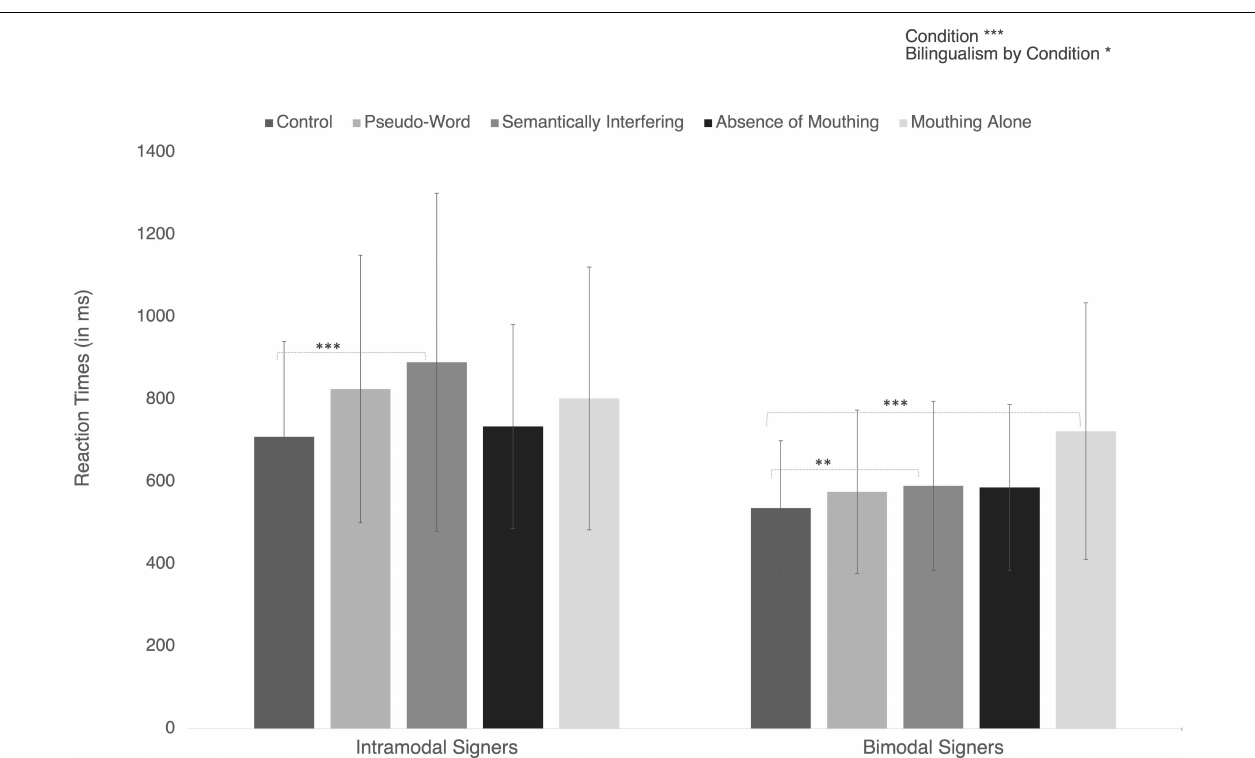
FIGURE 3 | Reaction times in the different in the two groups of bilinguals. Error bars represent standard deviations. Significant post hoc comparisons are indicated with conventional asterisks ( ∗ p < 0.05; ∗∗ p < 0.01; ∗∗∗ p <